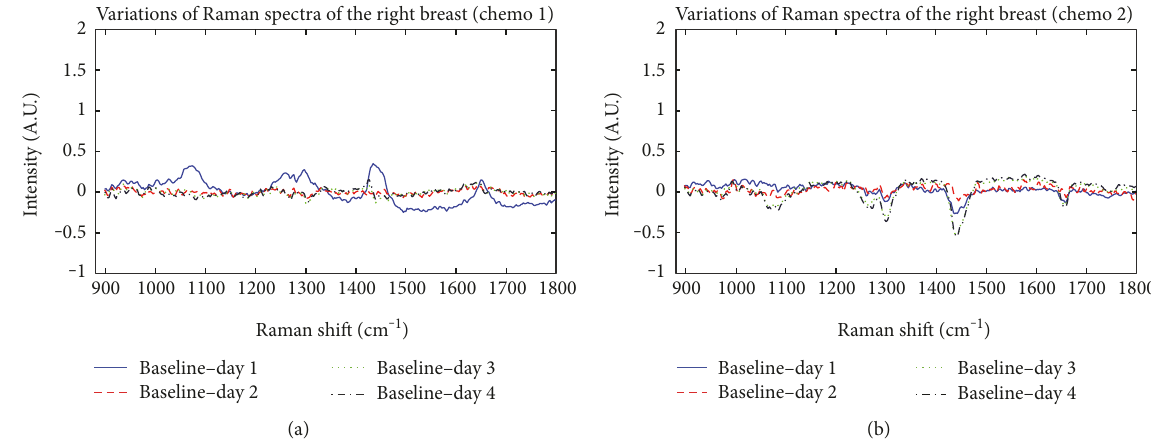
Figure 9: Variations of Raman spectra with regard to the baseline (chemo only group, baseline means the day high-dose chemotherapy was started). No breast tumor growth was induced. Day n means n day postchemotherapy.